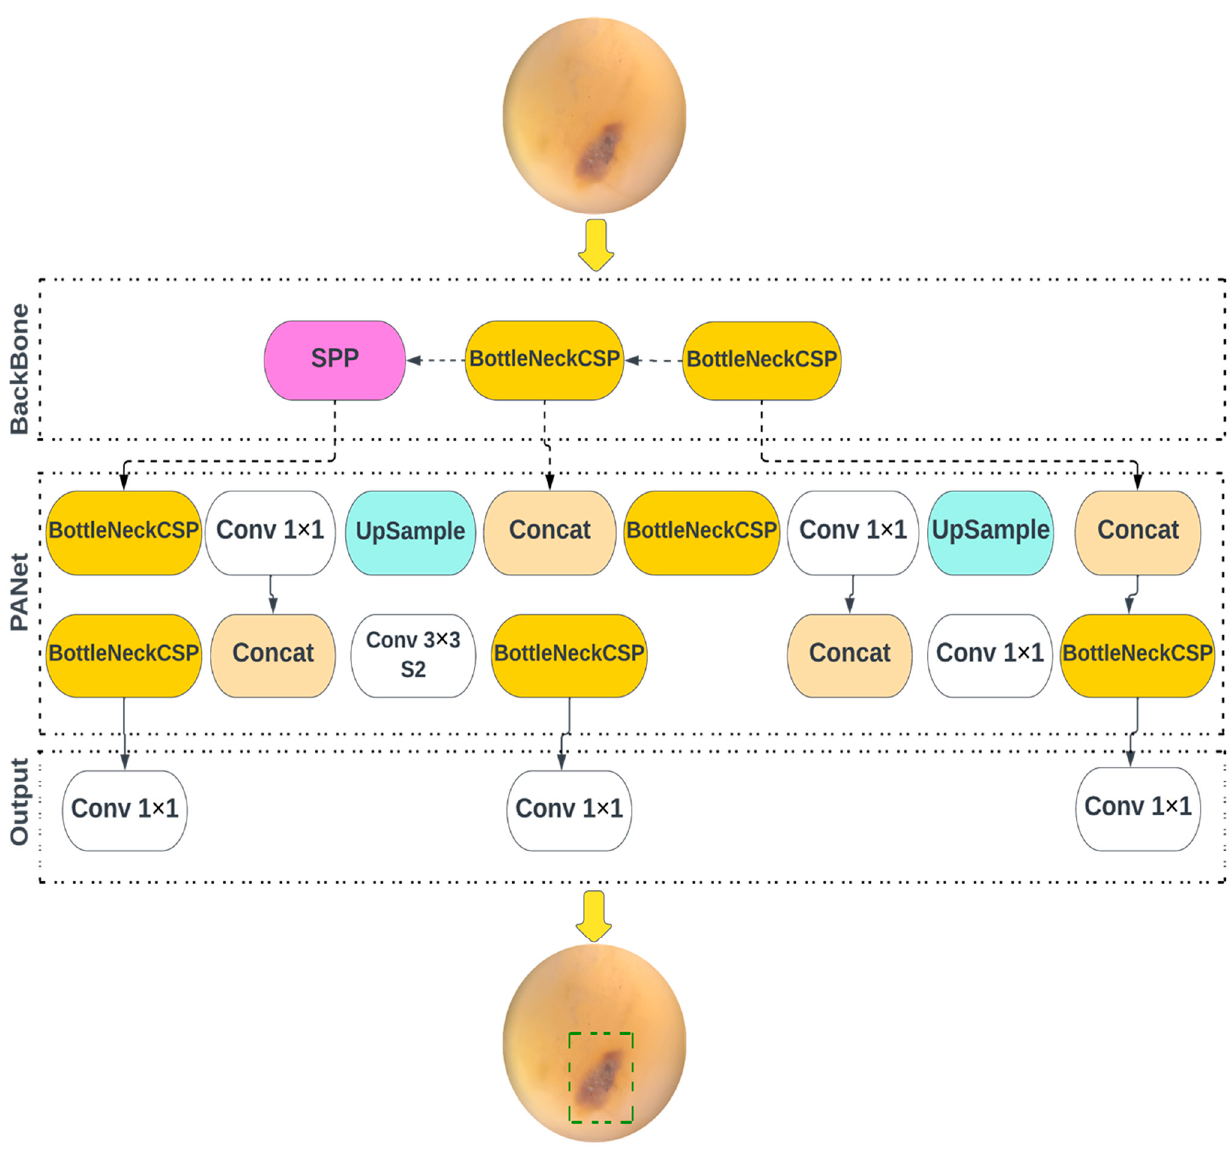
Figure 3. Overview of the object detection architecture deployed for caries diagnostics.